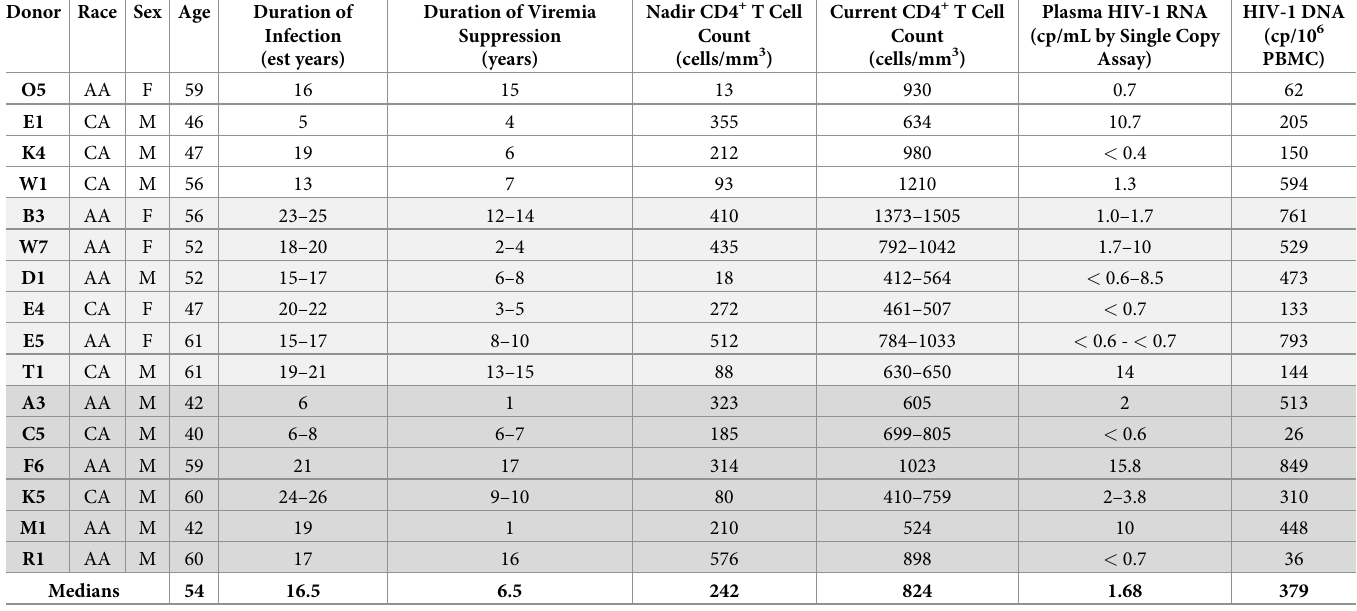
Table 1. Donor characteristics.